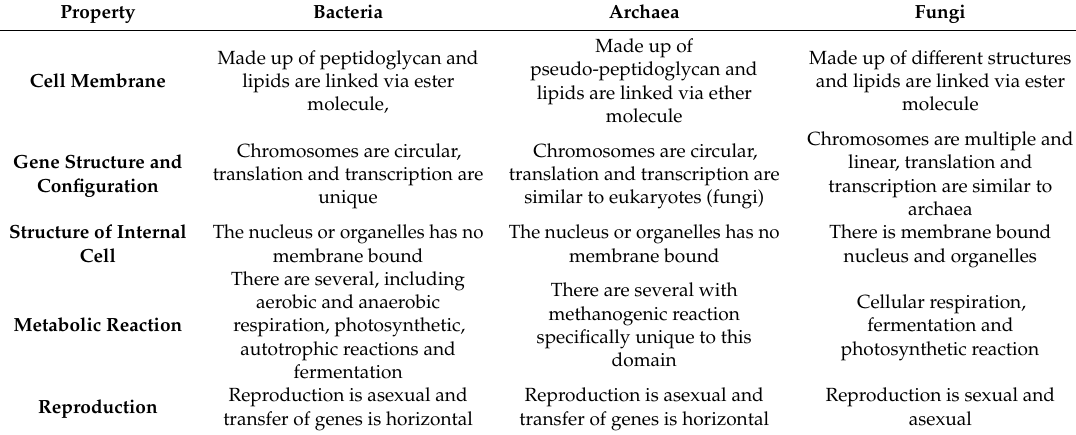
Table 2. Microbial Domains Comparisons